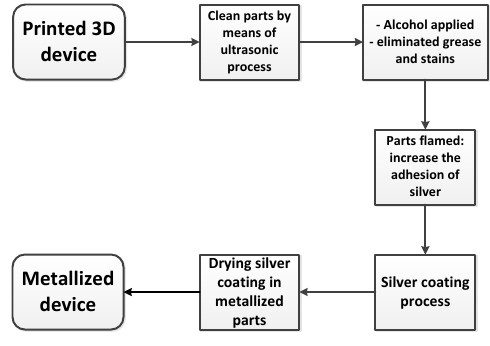
Figure 5. Flowchart for the metallization process of the directional coupler.